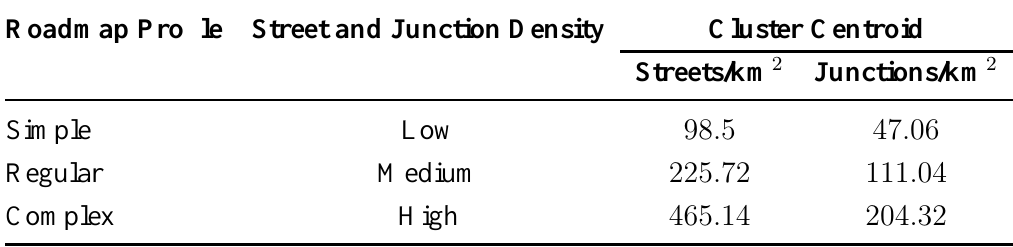
Table 11. Roadmap Profiles